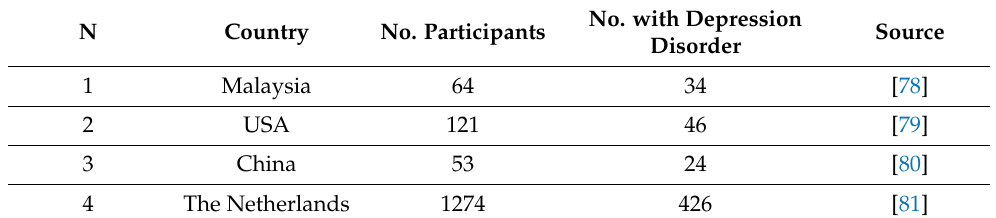
Table 2. Available open datasets for diagnostics of depression by EEG.